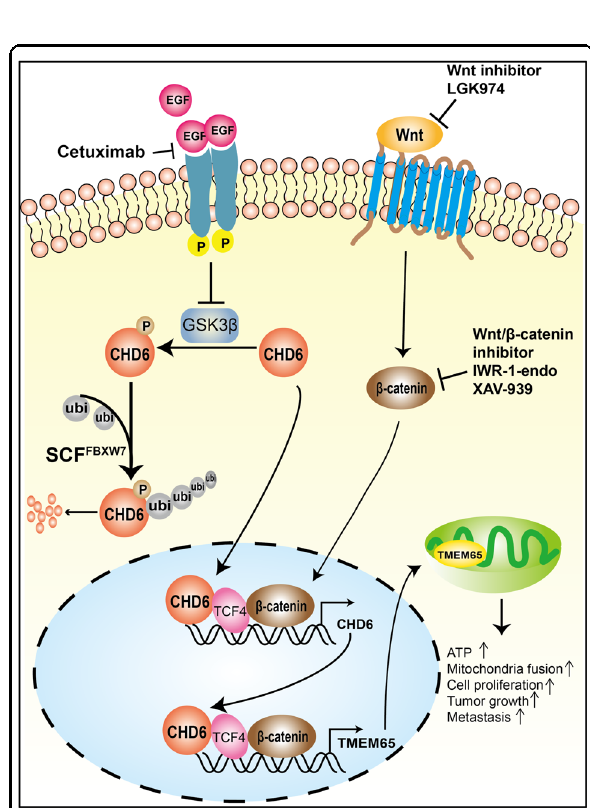
Fig. 9 CHD6-TMEM65 axis is regulated by both EGF and Wnt signaling pathways in promoting cancer growth. Model depicts that CHD6 regulates mitochondrial functions by promoting transcription of TMEM65 in response to EGF and Wnt stimulation. Upon activation of the EGFR-GSK3 β axis, CHD6 is not vulnerable to FBXW7-mediated ubiquitination and is thus stabilized. Under the activation of Wnt signaling, β -catenin/TCF4 directly bind to the promoter of CHD6 to enhance its transcription. CHD6 in turn facilitates transcriptional activity of β -catenin/TCF4 (Wnt signaling) to enhance the expression of TMEM65 , thereby facilitating tumorigenesis via regulating mitochondrial dynamics, ATP production, and